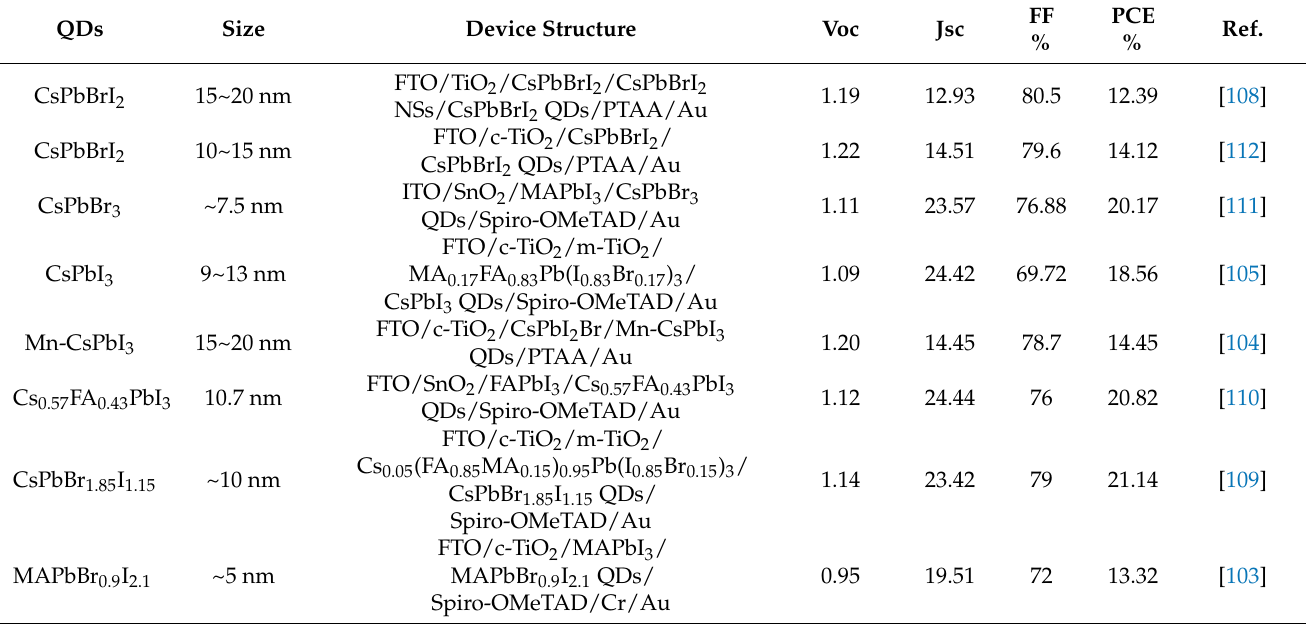
Table 5. Details of PQDs as the perovskite/HTL interface